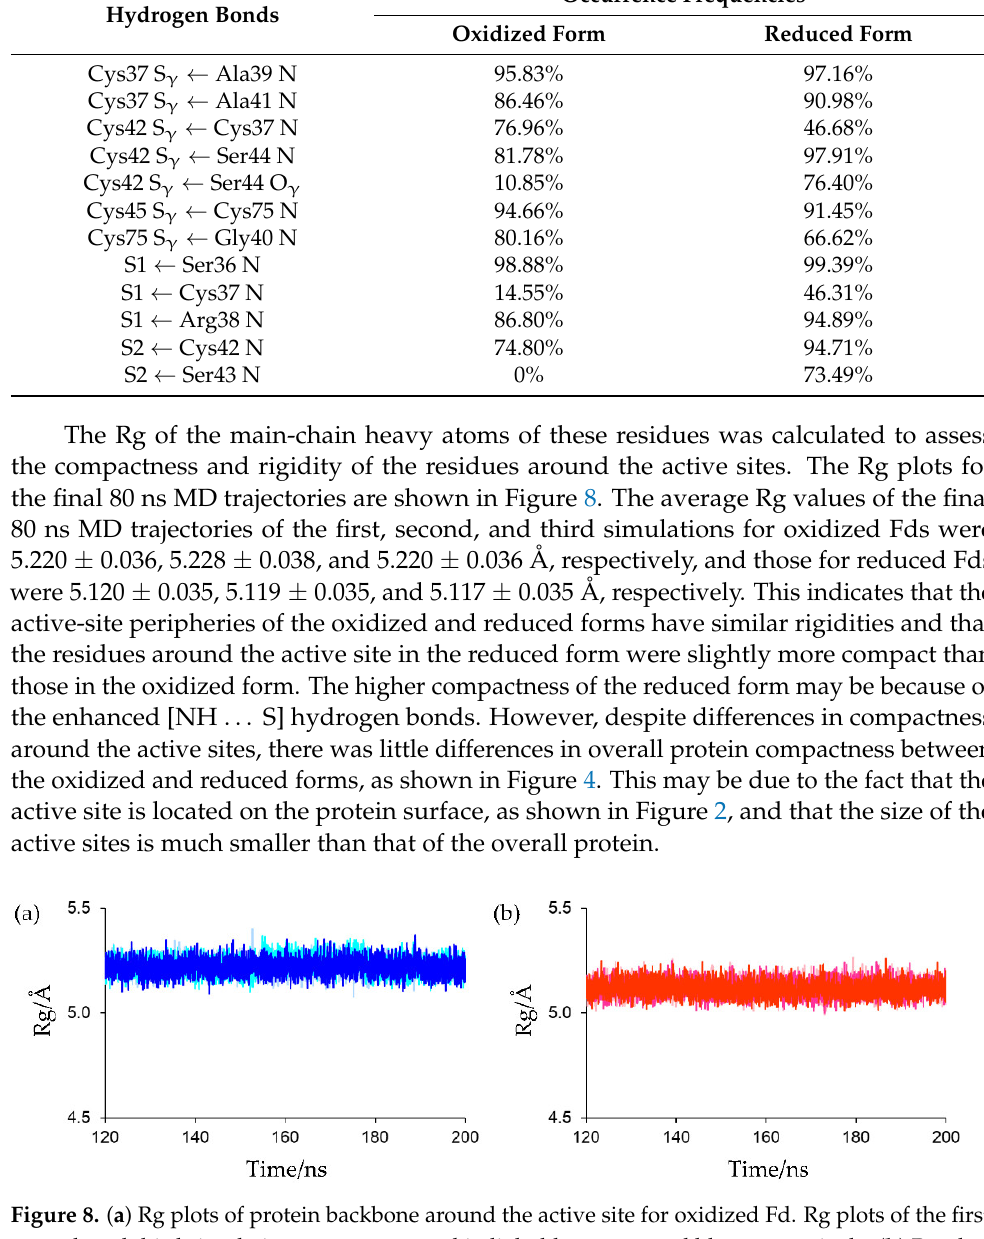
Table 1. Highly frequent [NH . . . S] and [OH . . . S] hydrogen bonds in oxidized and reduced forms.